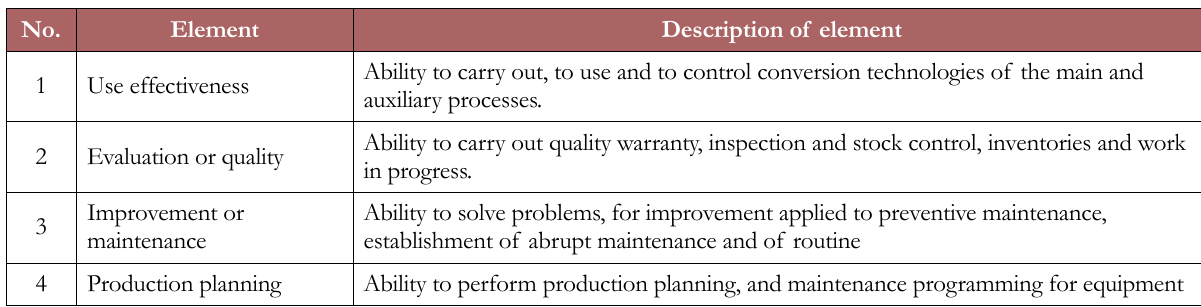
Table 1. Description of the elements by dimension for DV and